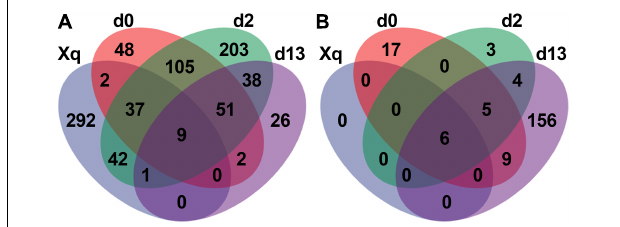
FIGURE 5 | Venn diagram showed the microbial species in Xiaoqu and fermented rice based OTUs obtained by sequencing. Bacteria (A) , and fungi (B)